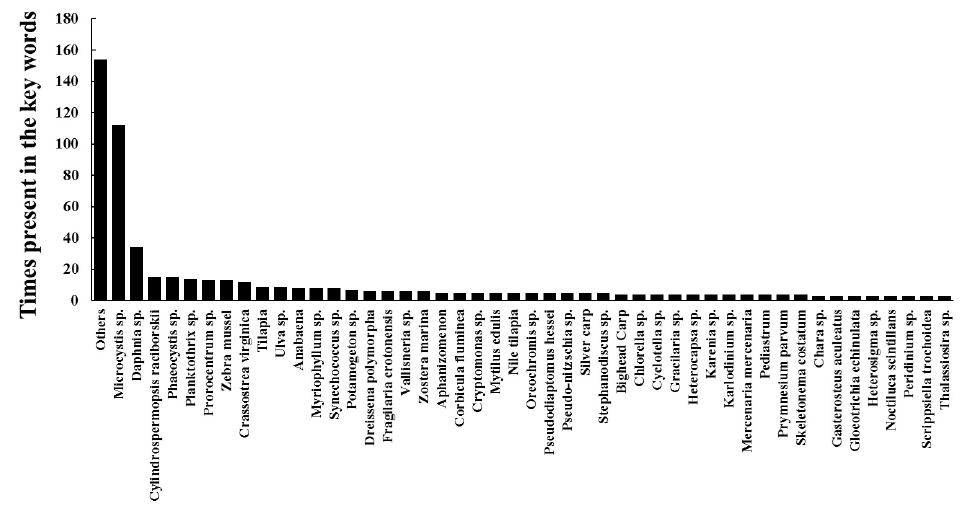
Figure 8. Organisms that appeared most often in the keywords of the articles on phytoplankton and eutrophication published between 2001 and